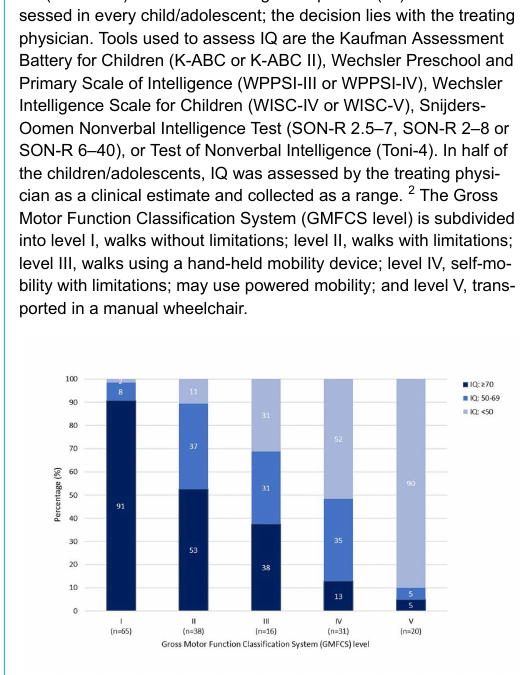
Figure 3: Intelligence quotient (IQ) 1 distribution by Gross Motor Function Classification System 2 in a subset of 170 children and adolescents included in the Swiss Cerebral Palsy Registry. The p- value calculated from chi-square statistics comparing GMFCS lev-